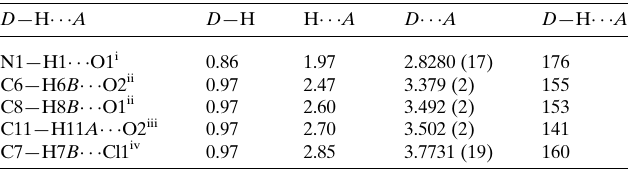
Figure 1 The molecular structure of the title compound, showing the atom labelling. Displacement ellipsoids are drawn at the 50% probability level.